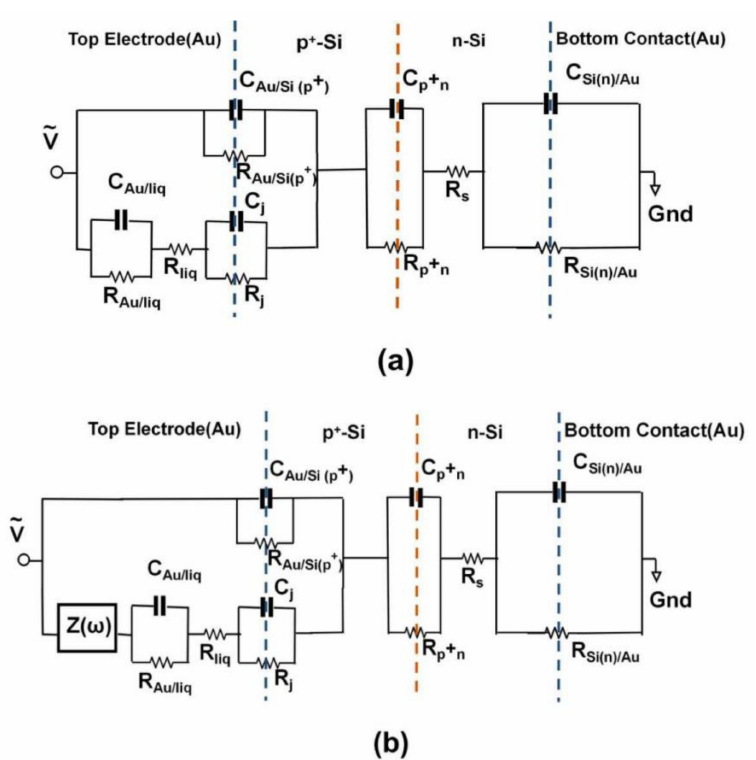
Figure 7. Equivalent circuit model of BS5 for ( a ) No Fill and 20 µ L DI water. The changes in impedance (Figure 5) after addition of 1 µ L, 2 µ L, 3 µ L, 4 µ L, and 5 µ L into the region of the ring top electrode are extracted by adding ( b ) Z( ω ) in series to the ring electrode impedance components of 20 µ L DI ( a ). Modeled values of RC pairs are listed in Table A2. The left blue, orange, and right blue dotted line indicates the interface between Au ring electrode and Si(p+), the position of p + n junction and the interface between Si(n) and Au bottom electrode,